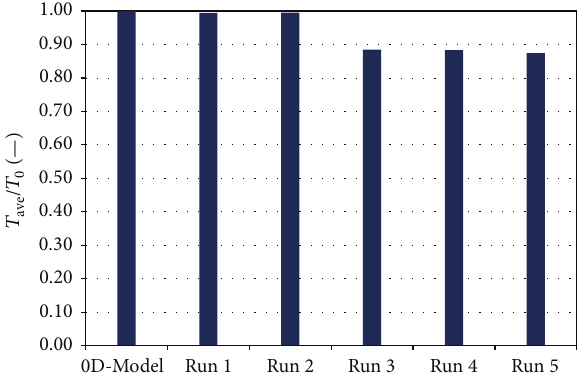
Figure 11: Dimensionless averaged torques.